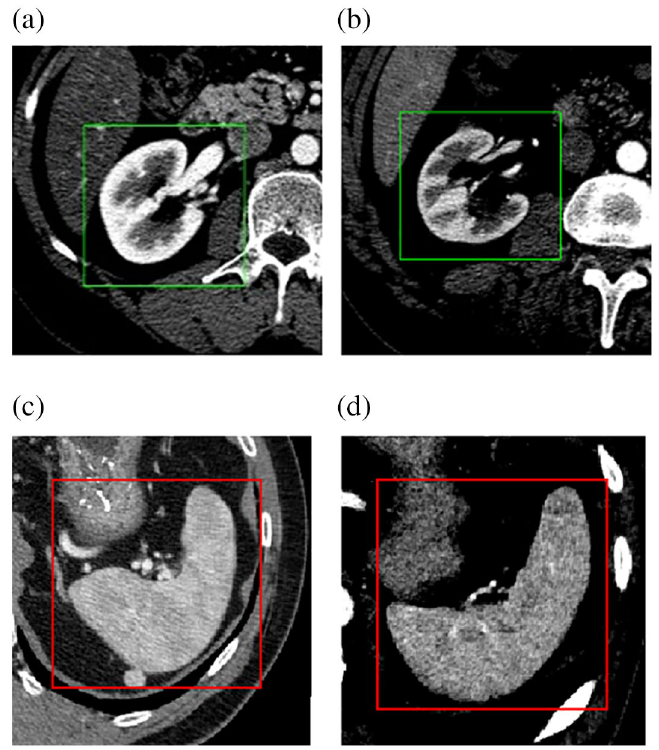
Figure 14. Example of four image slices with found ROI. Images ( a ) and ( b ) show recognition of the kidney, while images ( c ) and ( d ) show its counterpart on the